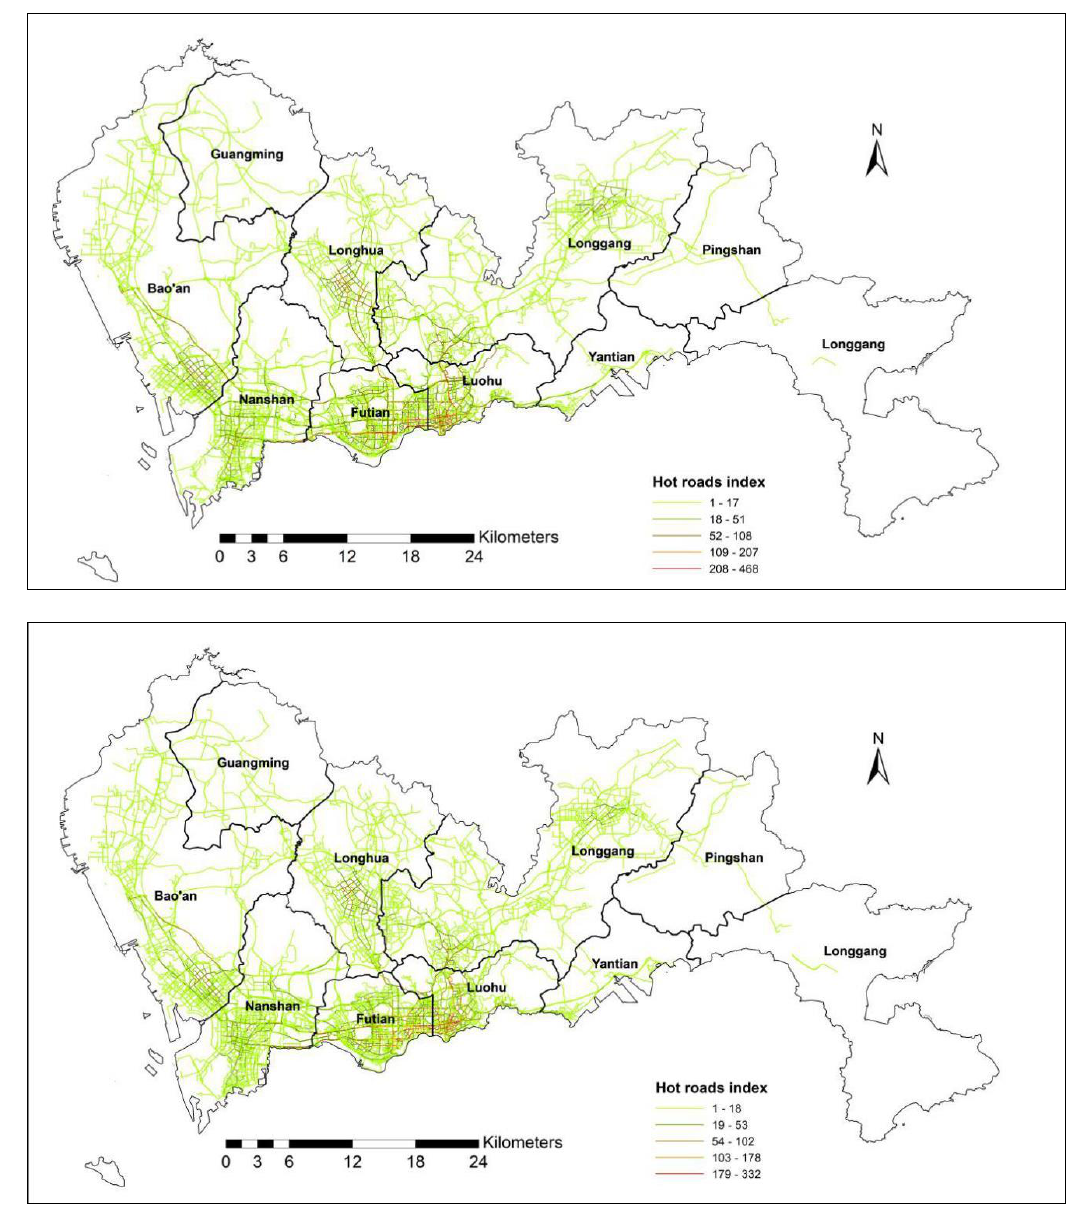
Figure 9. Hot roads in taxi trips ( top ) and shortest paths ( bottom ).